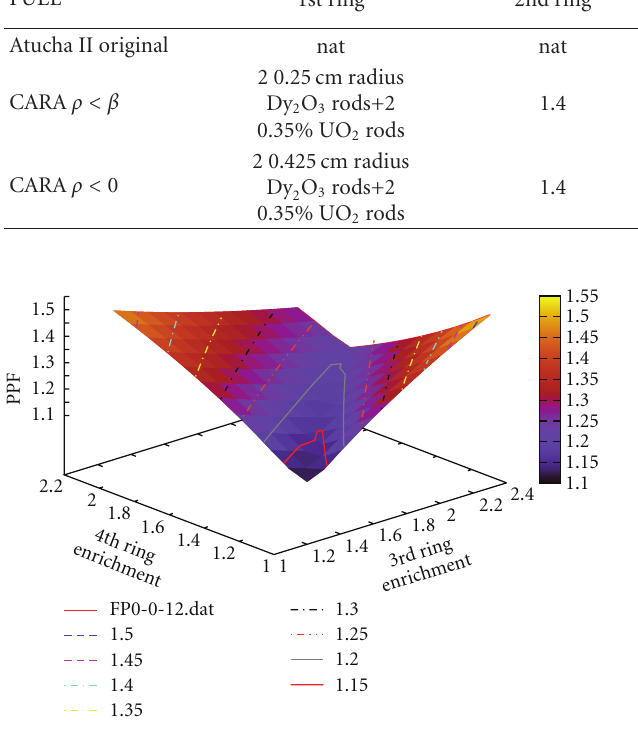
Figure 10: PPF dependence on 3rd and 4th ring enrichments.